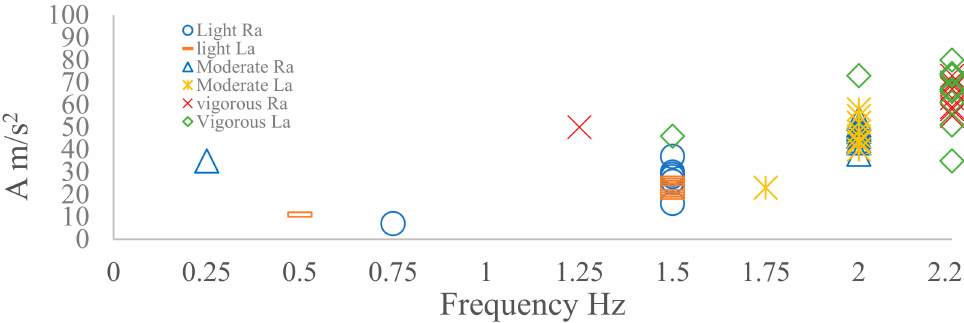
Figure 5. Right and left ankle dominant frequency and amplitude for di ff erent walking intensities.